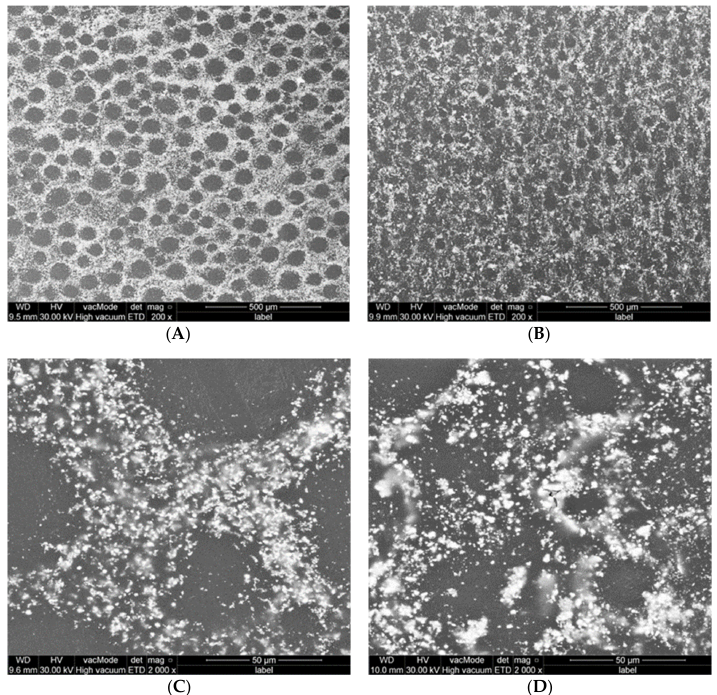
Figure 9. SEM photos of PMMA-Ag nanocomposite discs ( A , C ) prepared by non- ethanol-assisted mixing and ( B , D ) by ethanol-assisted mixing.